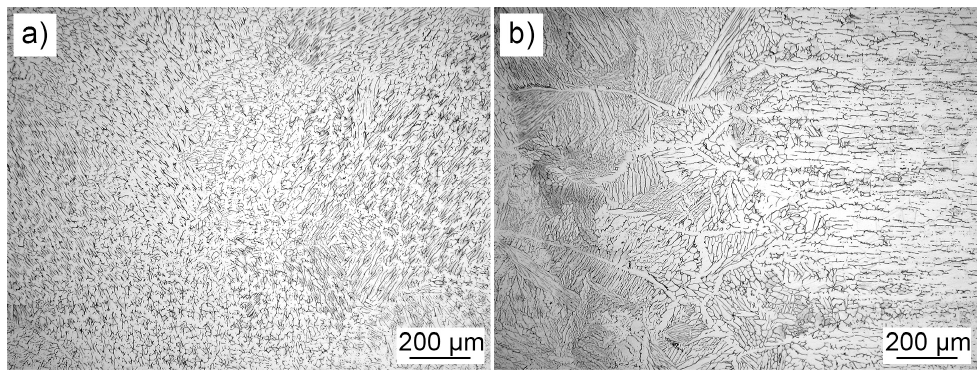
Figure 4. Microstructures of the 5Ti specimen obtained by light microscope: weld metal ( a ); weld interface ( b ).